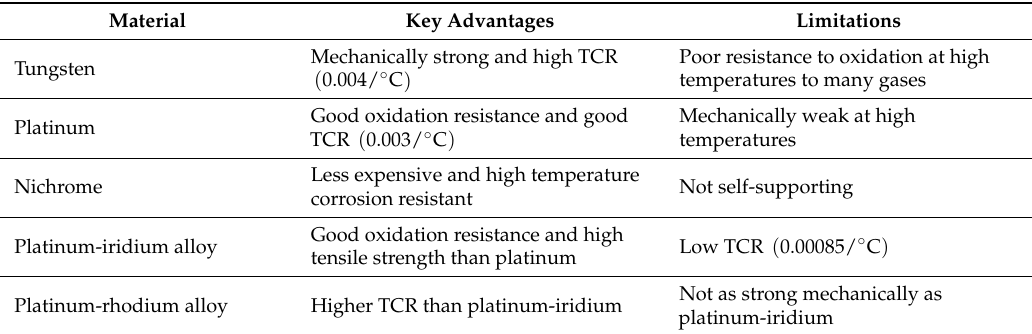
Table 2. Key advantages and drawbacks of commonly employed heater metal and alloys at high